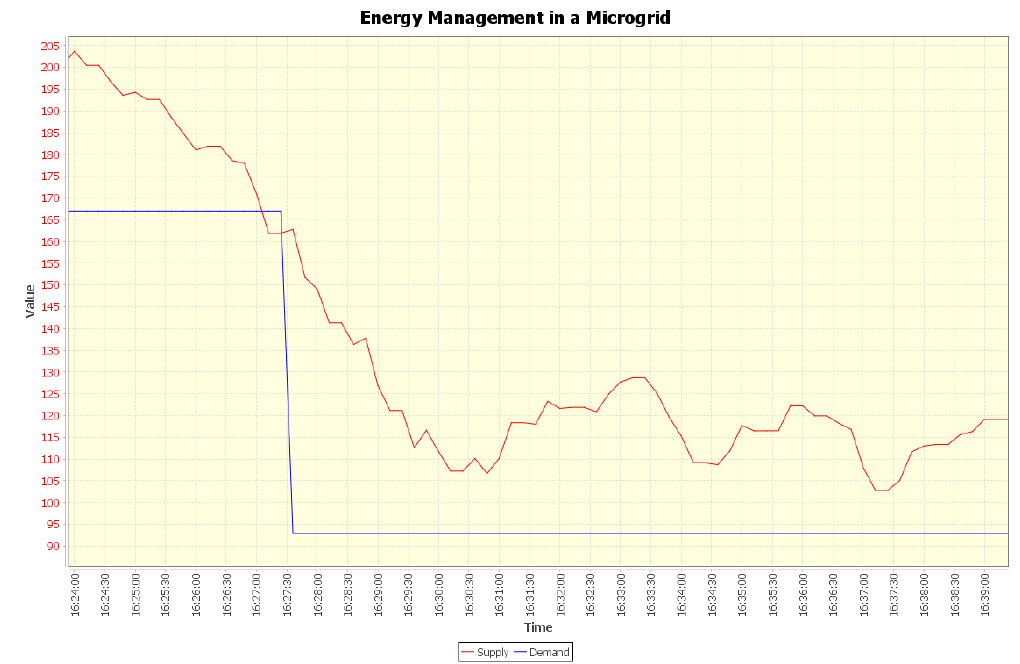
Figure 12. Multiagent System without Event Driven